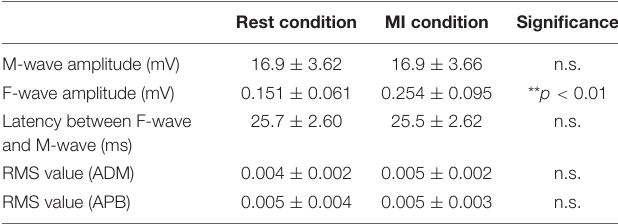
TABLE 2 | The M-wave and F-waves and background electromyography (EMG) for the motor imagery (MI) task. Rest condition MI condition